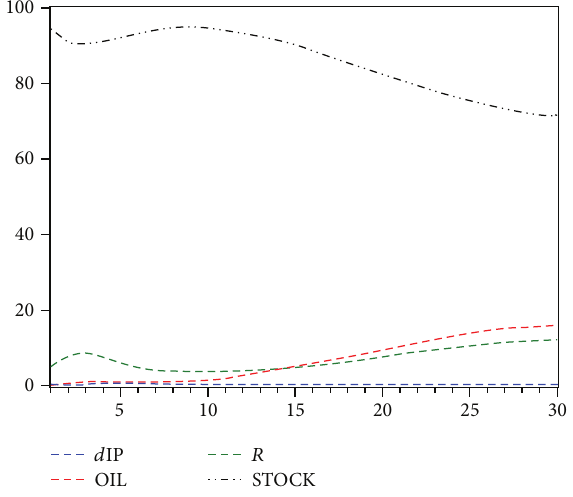
Figure 3: Variance decomposition of